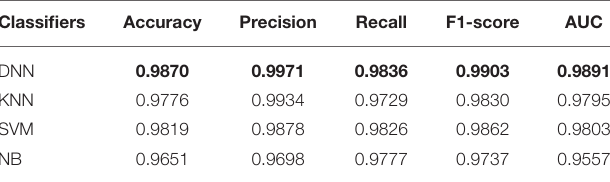
TABLE 4 | Results with different classifiers (the accuracy, precision, recall, F1-score, and AUC value are average).